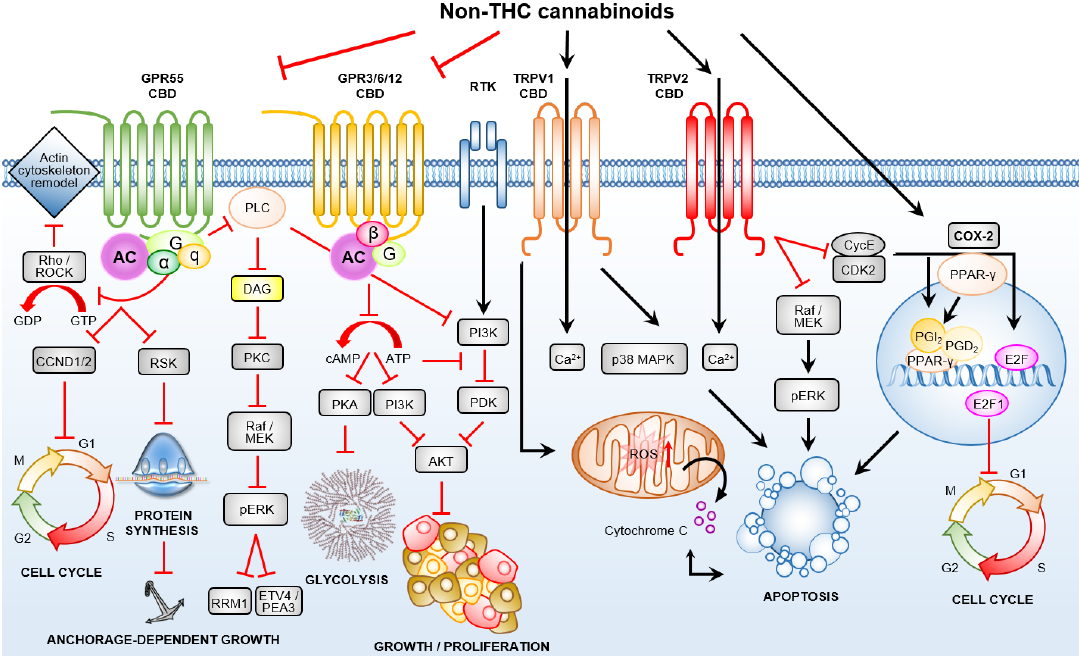
Figure 1. Transient receptor potential channels of the vanilloid subtype proteins and G-protein-coupled receptors mediates the anti-cancer e ff ects of non-tetrahydrocannabinol (non-THC) cannabinoids. Cannabidiol (CBD) antagonises the de-orphaned G-protein-coupled receptor GPR55, and agonise transient receptor potential vanilloids (TRPVs), TRPV1 and TRPV2. CBD may out-compete the natural ligands of orphaned G-protein-coupled receptors (GPCRs), GPR3, GPR6 and GPR12, and this in turn suggests a mechanism for the inhibition of tumour growth and the induction of cell cycle arrest, and / or may even promote selection of cancer stem cells (CSCs).